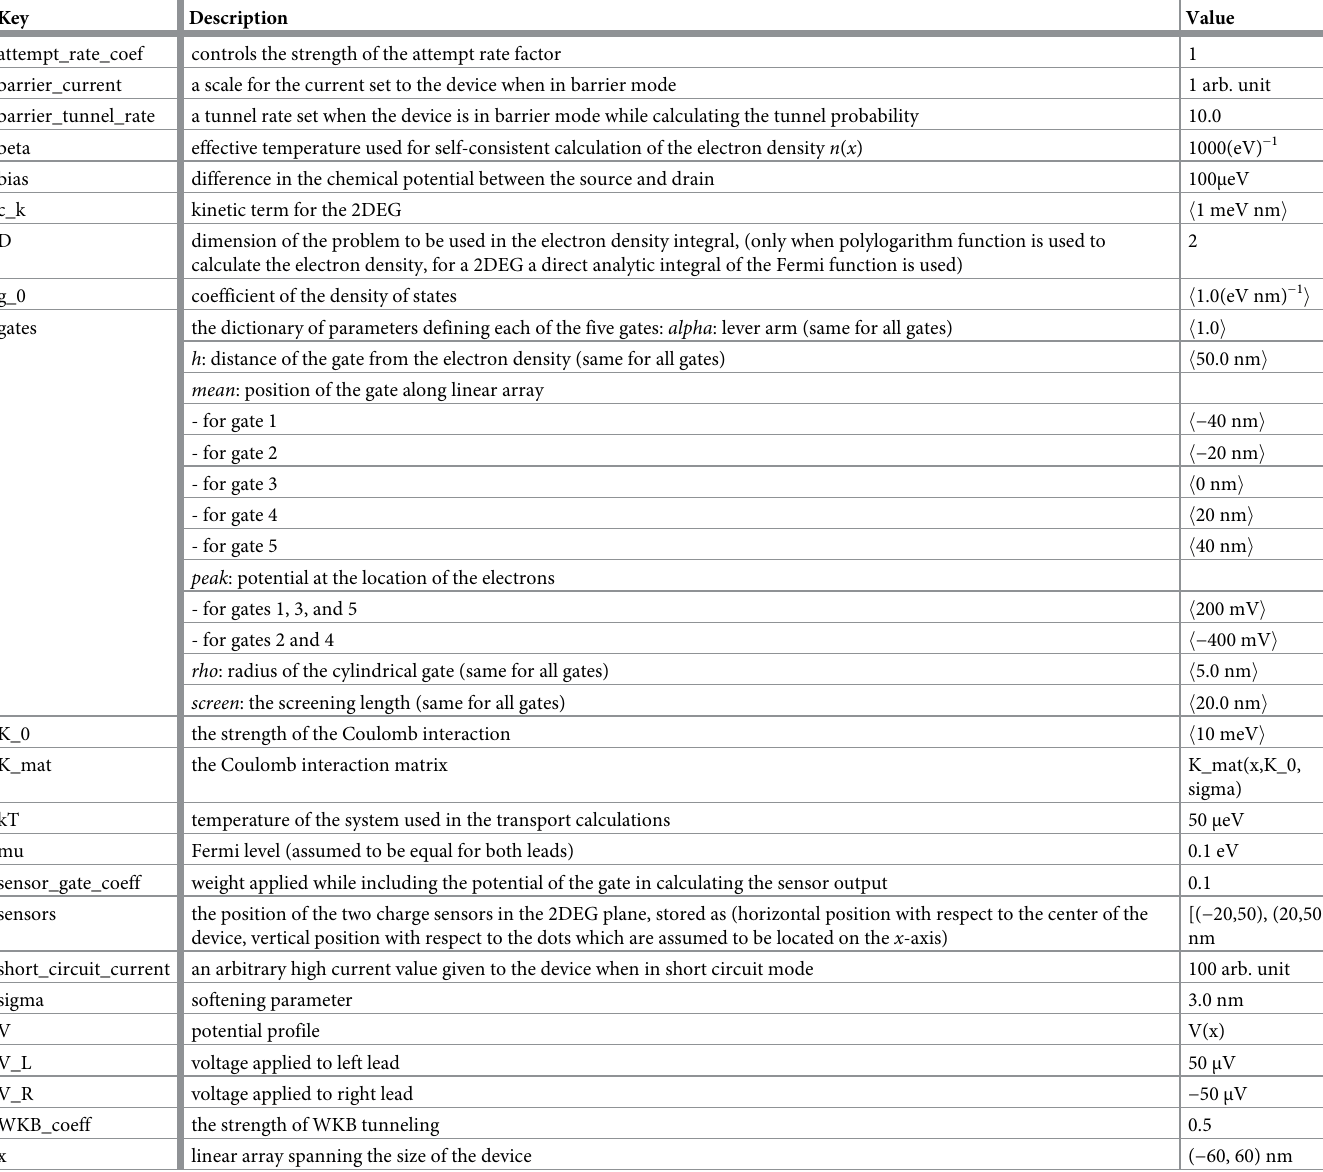
Table 3. The physical parameters of the devices, stored as a dictionary ‘physics’. Fixed values are given explicitly. Varied parameters, given in angle brackets, were ran- domly sampled from a Gaussian distribution with the given mean value μ and standard deviation set to 0.05| μ | (unless stated otherwise). Key